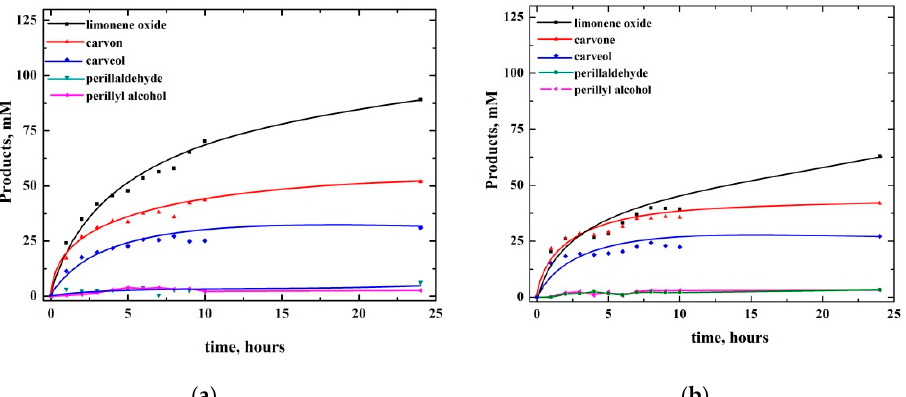
Figure 2. Dependence of products concentrations on time for oxidation of 1 M limonene with ( a ) dioxygen (p O2 = 1 atm), ( b ) air (p O2 = 0.2 atm) catalyzed by 1mM [(N4Py)Fe II ] 2+ in